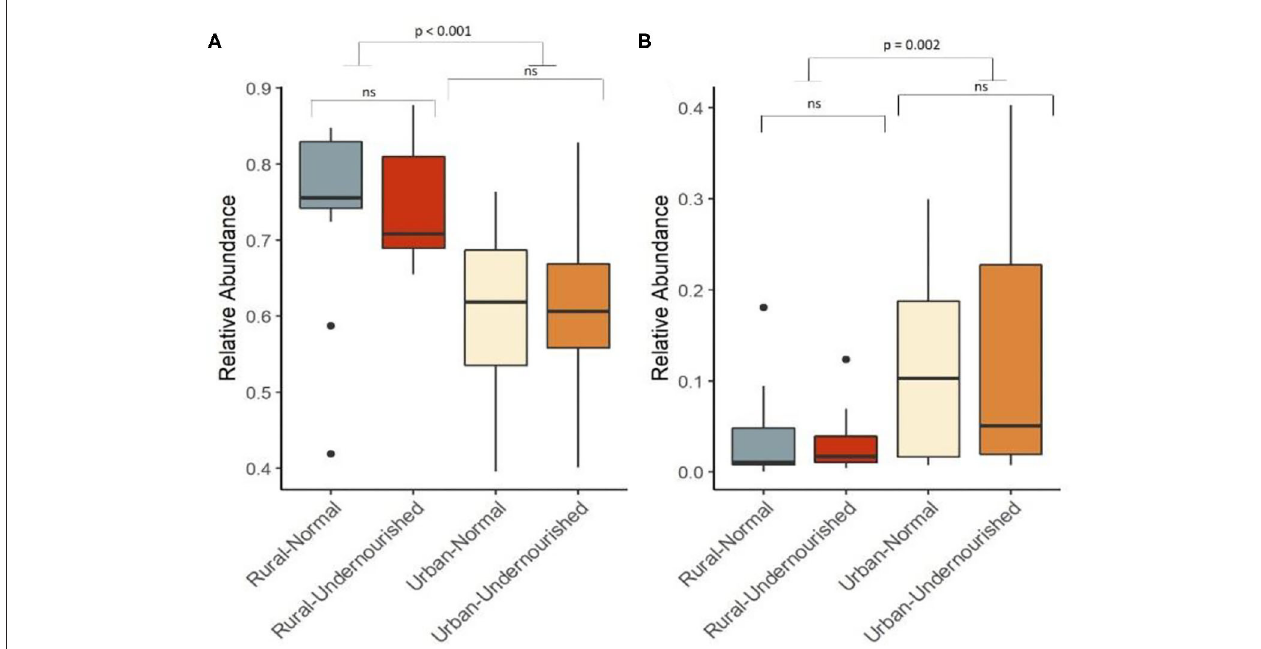
FIGURE 1 | Box and Whisker plot depicting relative abundance of significant phylum. (A) Firmicutes and (B) Proteobacteria in undernourished and nourished from rural and urban-slum settings. p -values indicate statistical significance from independent t -tests comparing nourished and undernourished study groups in both the locations (i.e., rural normal vs. rural undernourished and urban normal vs. urban-undernourished) and independent t -test based on location (i.e., rural vs. urban-slum). Box-and-whisker plots show high, low, and median values, with lower and upper edges of each box denoting first and third quartiles, respectively. ns indicates non-significant p -values. Black dots represent the